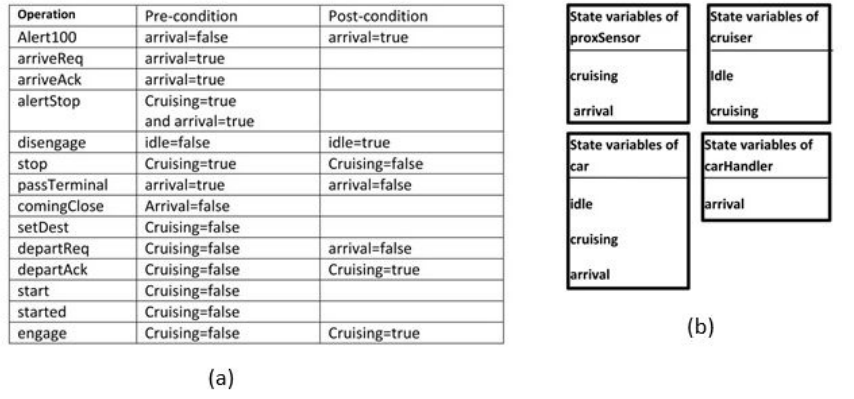
Figure A4. System Constraints Table and State Variables of the Components of the Railcar Scenario. ( a ) System constraints table of of railcar. ( b ) State variables of the components of